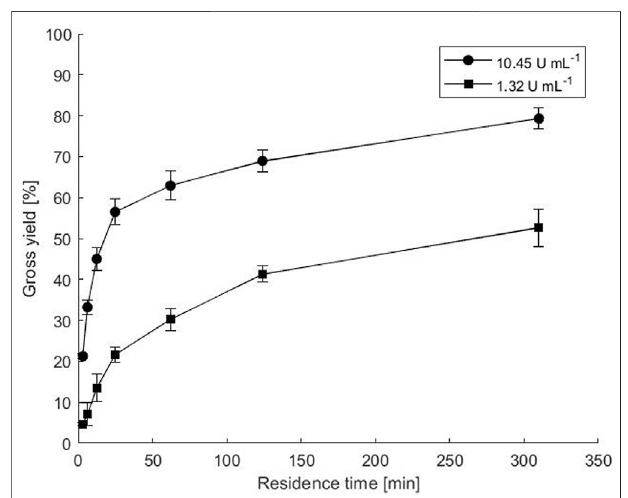
FIGURE 4 | Biotransformation in a microbioreactor between two plates with co-immobilized ATA-v1 and PLP in copolymer hydrogel. The points represent the gross yield of ACP as a function of residence time. Reactions were performed at various immobilized enzyme concentrations with 0.1 mM PLP cofactor at 50 ° C and with equimolar substrate concentrations of 40 mM. Error bars indicate standard deviations of